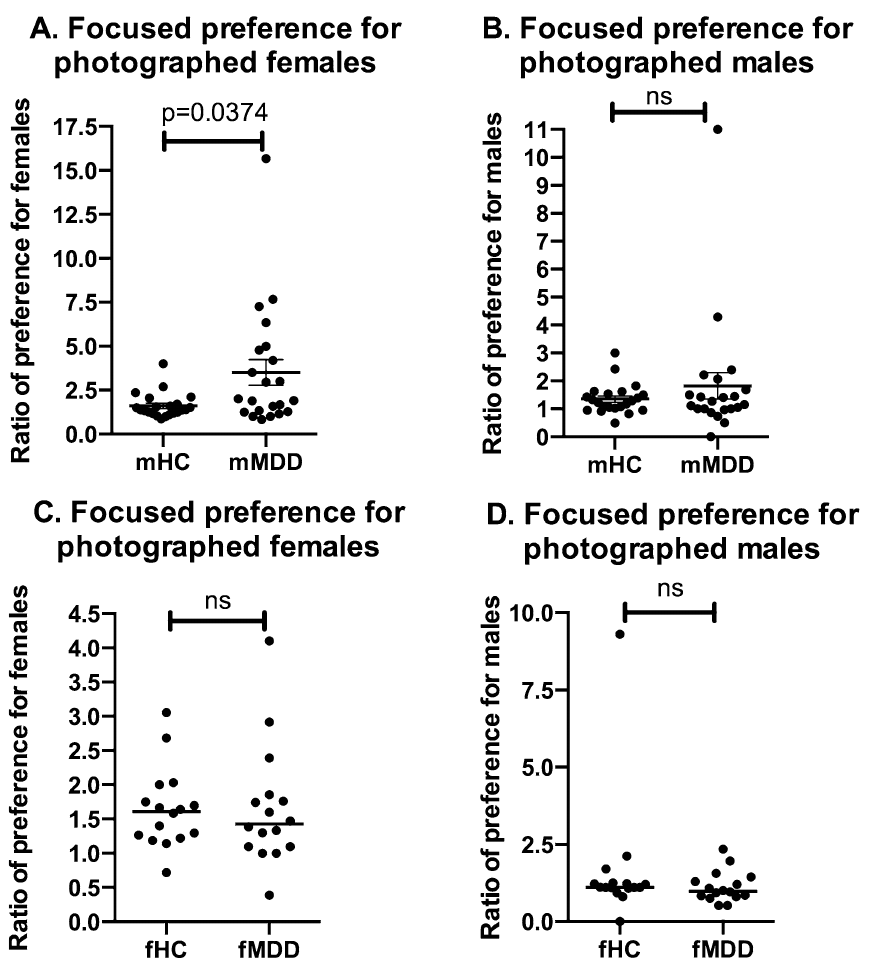
Figure 1. Group comparison of focused preference index for photographed partners. Dot plots show differences in ratio of preference for male and female partners (i.e. ration of focused preference index) between HC and MDD males ( A , B ), and HC and MDD females ( C , D ). Mann–Whitney’s U test was performed for group comparison, and MDD males’ focused preference was higher than HC males ( A ). Horizontal bars represent the median values of each group. Male HC (mHC): N = 22; male MDD (mMDD): N = 22; female HC (fHC): N = 16; female MDD (fMDD): N = 16. HC healthy controls, MDD major depressive